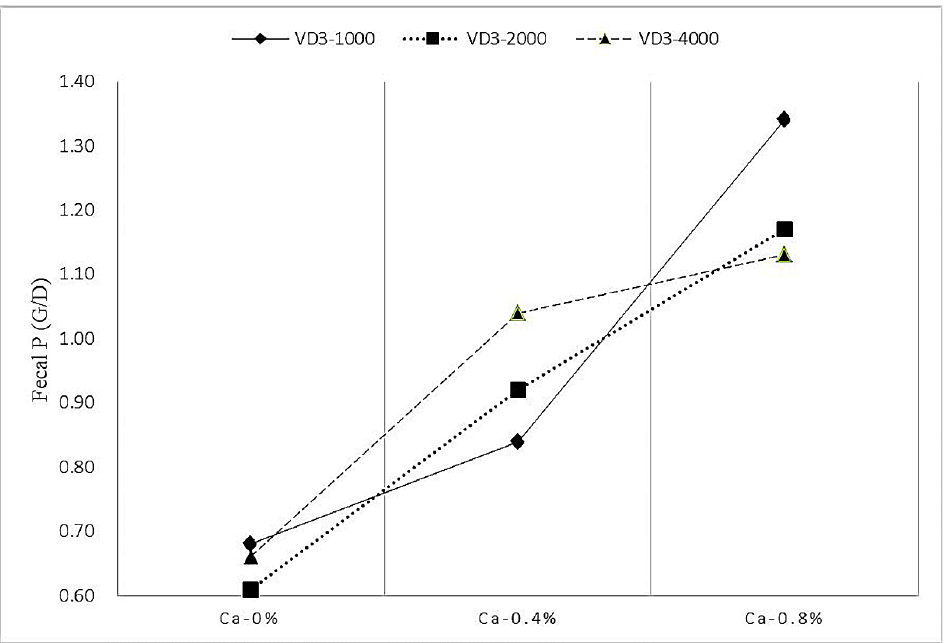
Figure 3. The effect of the interaction between Ca and VD 3 on the fecal P in growing blue foxes. VD 3 = vitamin D 3 . BV = biological value.